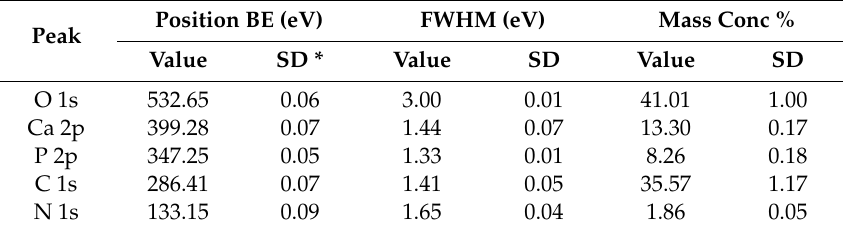
Table 5. Detailed data of XPS analysis for considered peaks – sample 5CC.